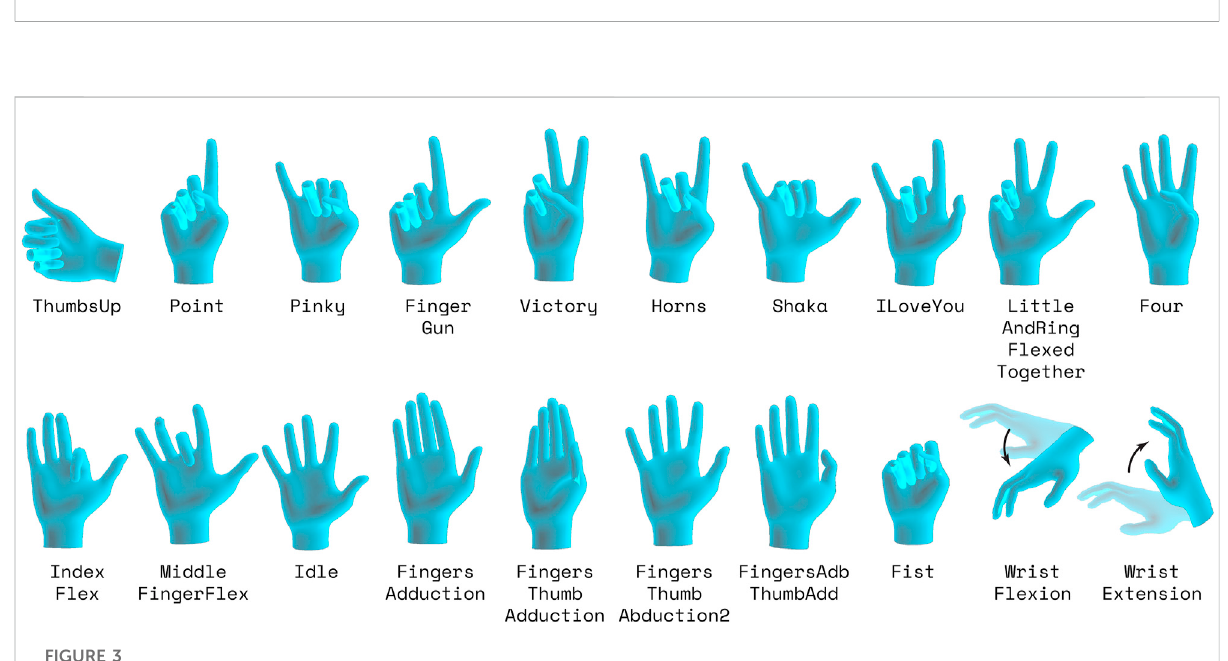
FIGURE 3 The 20 gestures for the In-Air Gestures Task, with the Idle pose being a representation of the general shape of the hand when subject rested.